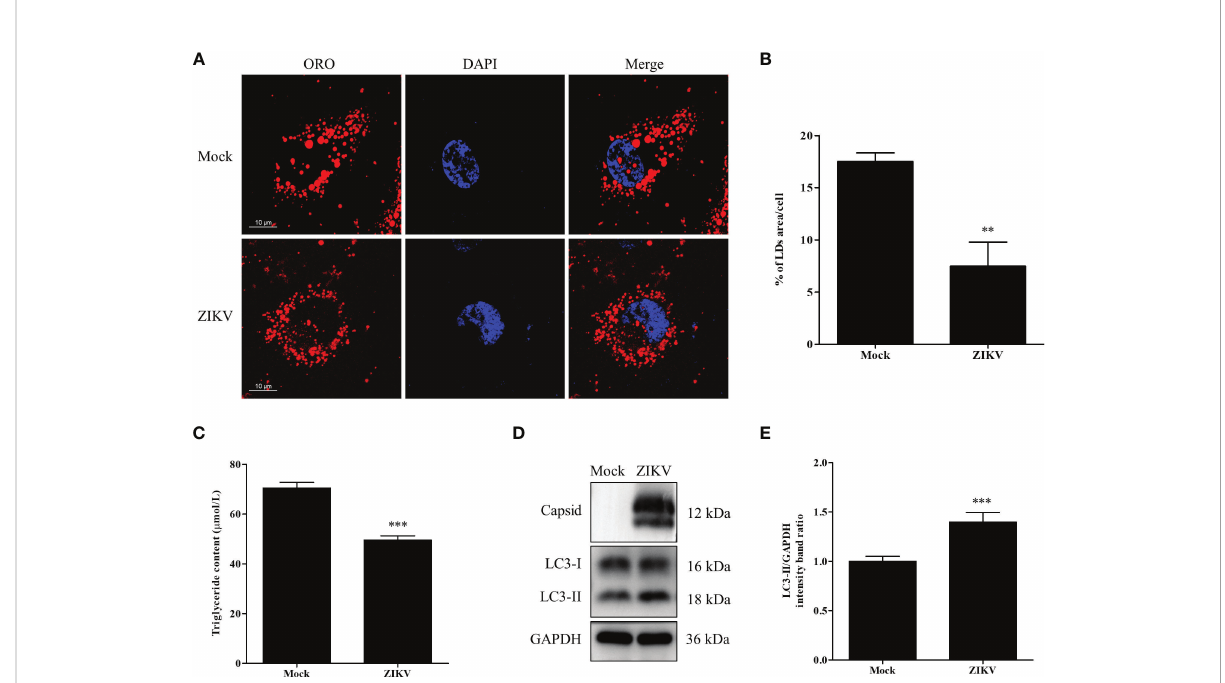
FIGURE 1 ZIKV infection induces lipophagy in human carcinoma cells. (A) Huh7 cells were infected with ZIKV at an MOI of 1 or mock-treated for 24 h. The cells were fi xed, stained with Oil Red O (ORO), and then observed under a confocal microscope. Bars, 10 µm. (B) Quanti fi cation of the ORO- positive area per cell was performed using Image J. (C) The intracellular triglyceride content in mock-treated or infected cells was quantitated using a triglyceride assay kit. (D) Western blot analysis of viral Capsid and LC3 protein levels. GAPDH was used as a loading control. The turnover of LC3-I to LC3-II was assessed in cells infected with ZIKV at MOI 0.5 or mock-treated cells. Cells were harvested at 24 h and stained with corresponding antibodies. Representative images are presented. (E) The intensity band ratio of LC3-II to GAPDH, as measured via densitometry. Data are presented as the mean ± SD from three independent experiments. ** p < 0.01, *** p <